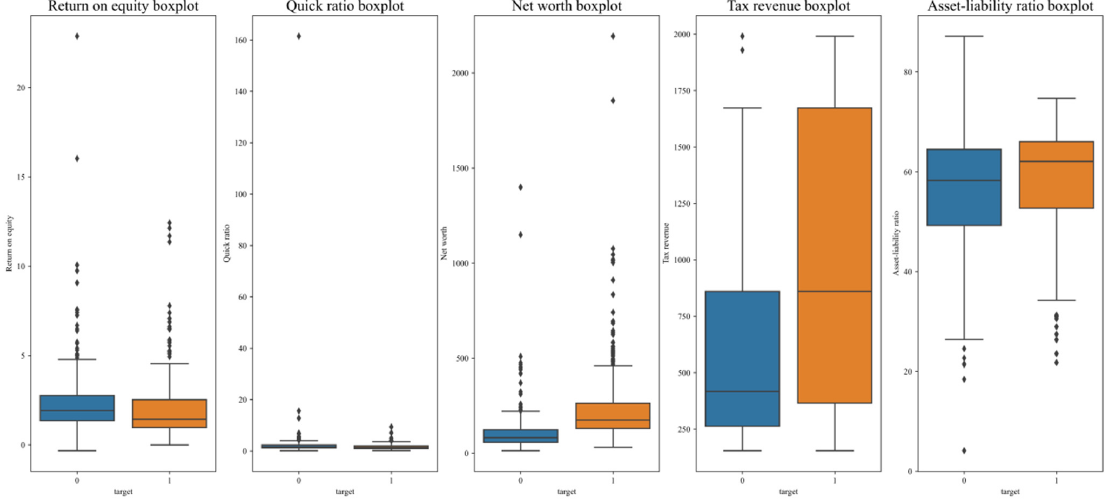
Figure 4. Analysis of financial indicators.